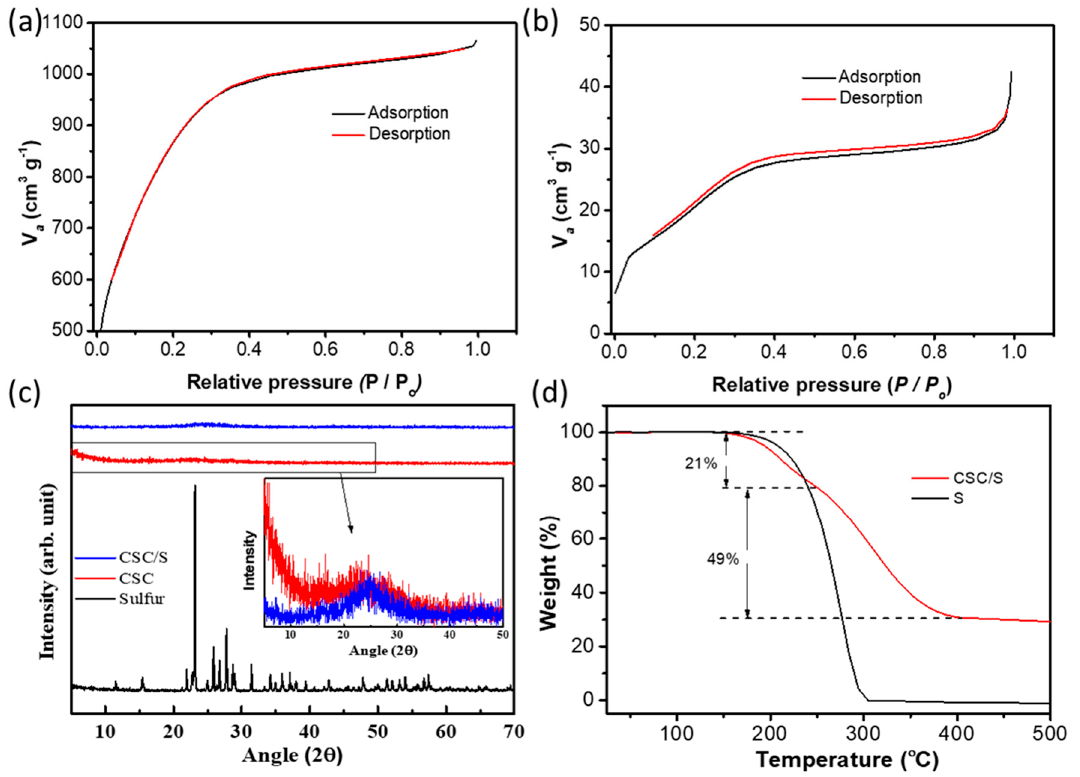
Figure 3. Nitrogen adsorption / desorption isotherms of ( a ) CSC and ( b ) CSC / S; ( c ) XRD patterns of pristine sulfur, CSC and CSC / S, and ( d ) TGA curves of pristine sulfur and CSC / S samples measured in a nitrogen atmosphere.